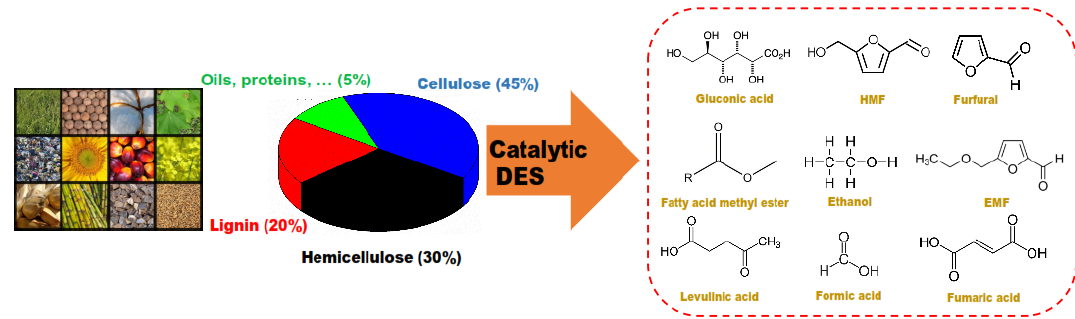
Figure 1. Conversion of biomass to value-added chemicals using catalytic deep eutectic solvents (DESs).